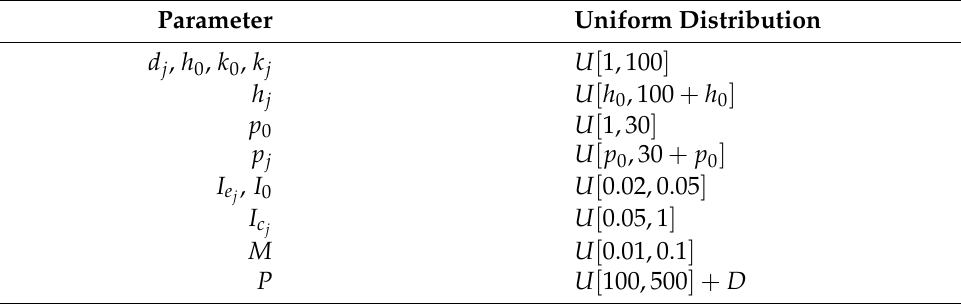
Table 6. Uniform distributions from which the model parameters were chosen.